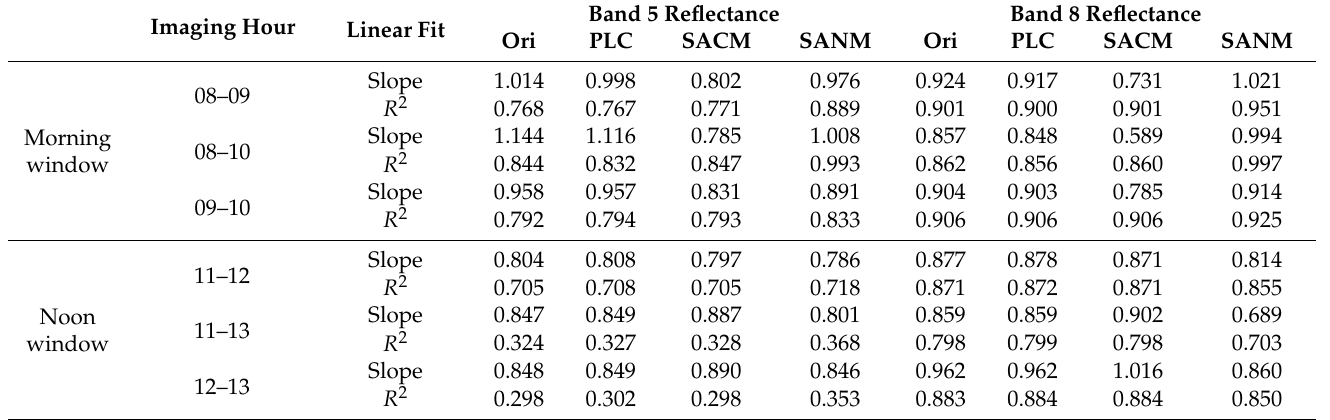
Table 3. Slope and R 2 of fit for GOCI band 5 reflectance and GOCI band 8 reflectance between different imaging